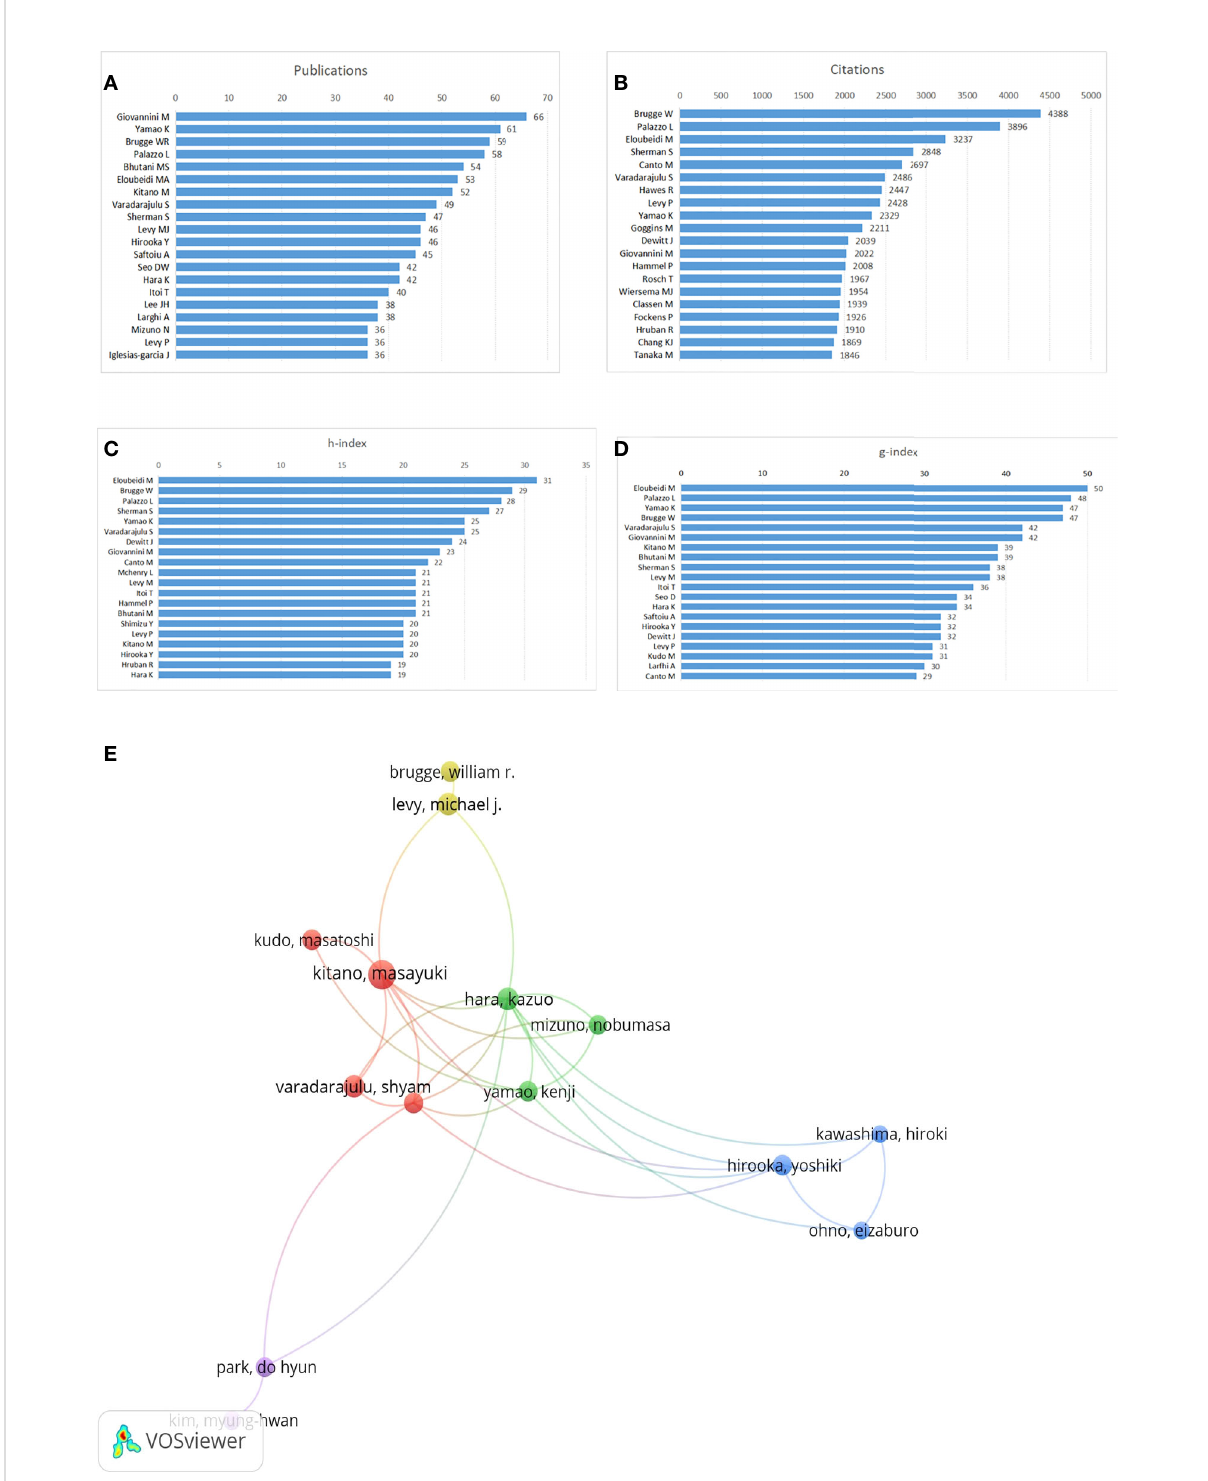
FIGURE 6 Author contributions. (A) Top 20 authors with the most publications, (B) Top 20 authors with the most ctiations, (C) h-index of publications from top 20 authors, (D) g-index of publications from top 20 authors, (E) Network map of co-authorship between authors with more than 30